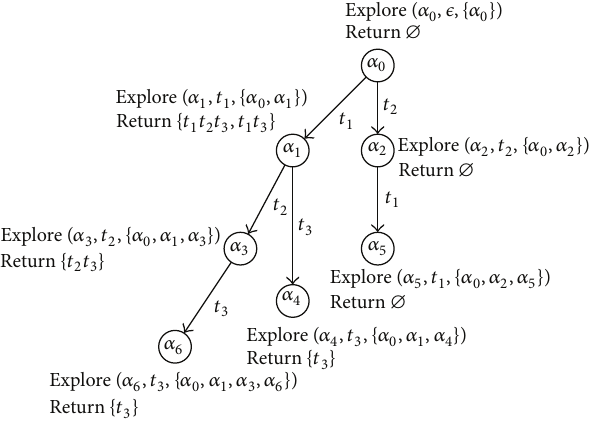
Figure 7: Applying Algorithms 1 and 2 on the TPN at Figure 1 for AG not 𝑝 1 + 𝑝 3 = 0